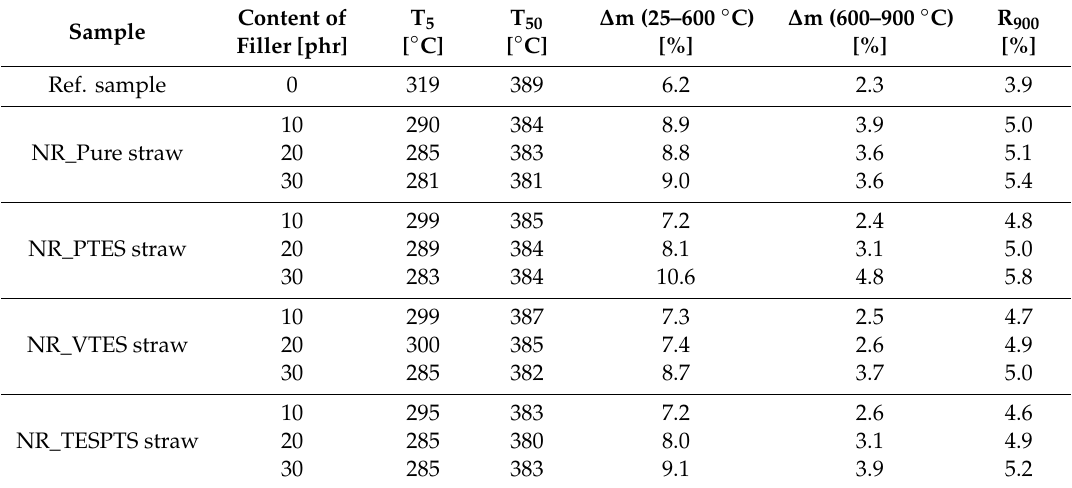
Table 5. Influence of straw modifications on the thermal stability of